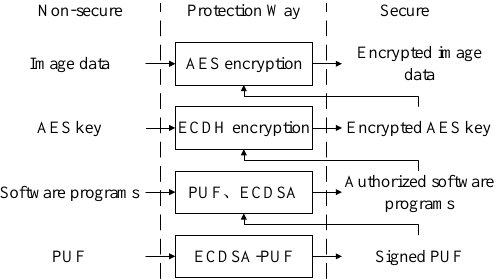
Figure 8. Triple-hybrid encryption system protection